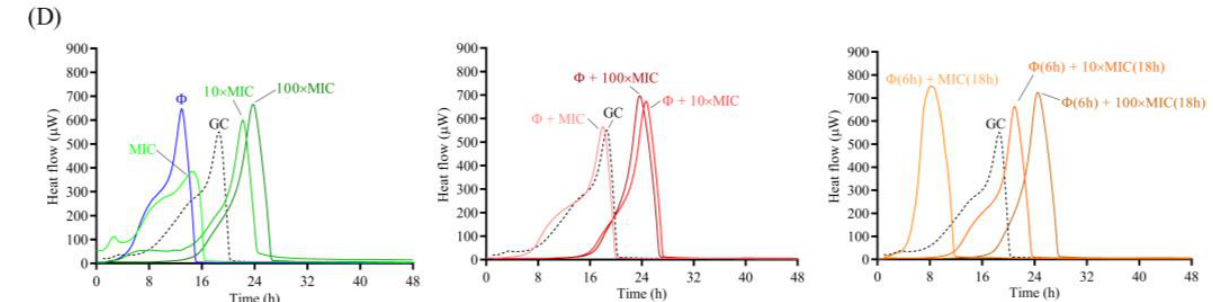
Figure 7. Calorimetric curves. Monitored heat flow ( µ W) of S. maltophilia ( A ) STM-1, ( B ) STM-19, ( C ) STM-33 and ( D ) STM-38 biofilms treated with CUB19 ( Φ at 10 8 PFU/mL) or cefiderocol at different concentrations (1 × , 10 × or 100 × MIC) as monotherapy (left column), or by simultaneous (middle column) and staggered (right column) phage-antibiotic combinations ( Φ + cefiderocol). Each curve shows the heat flow produced over time by viable bacteria in the biofilm after 24 h of treatment. GC represents the growth control sample not exposed to any antimicrobials. Data of a representative experiment are reported.